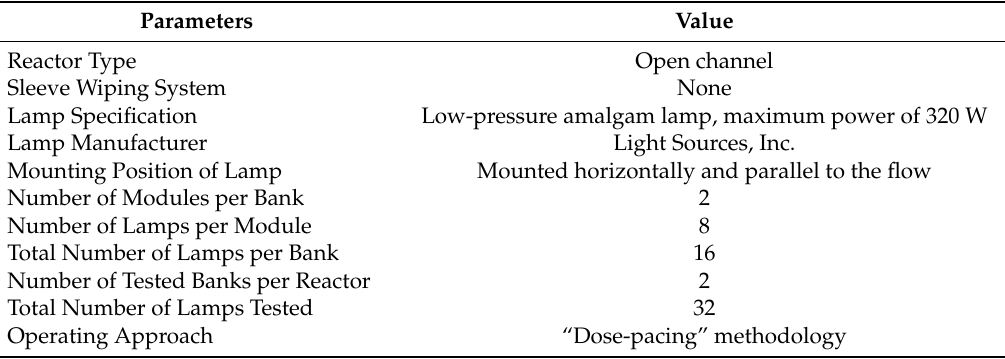
Figure 1. The computational model for geometry defeaturing evaluation for an open-channel-type UV reactor. The lamp power line, water-gate, inflow-reservoir, and lamp supports are defeatured sequentially. Note that only symmetrical models are used for computational fluid dynamics (CFD) simulation in order to reduce the computational cost and convergence time. Table 1. Specifications of the UV reactor for Title22 bioassay validation and CFD modeling.